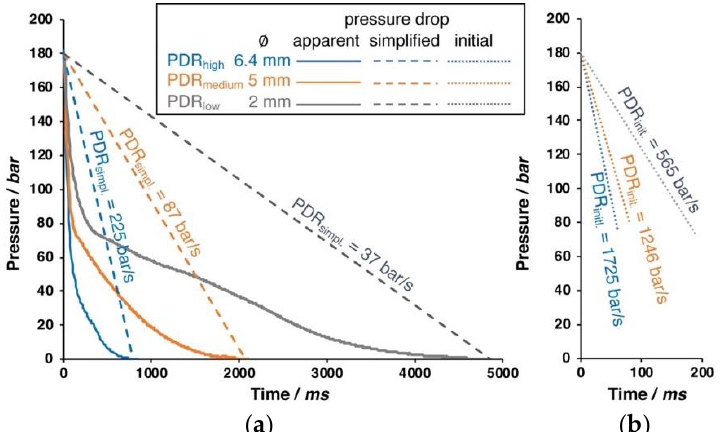
Figure 2. Different pressure drops that can be realized with different pipe diameters. ( a ) Apparent pressure drop (solid line) and simplified linear pressure drop (dashed line). ( b ) Close up of the initial pressure drop (dotted line) during the first milliseconds.